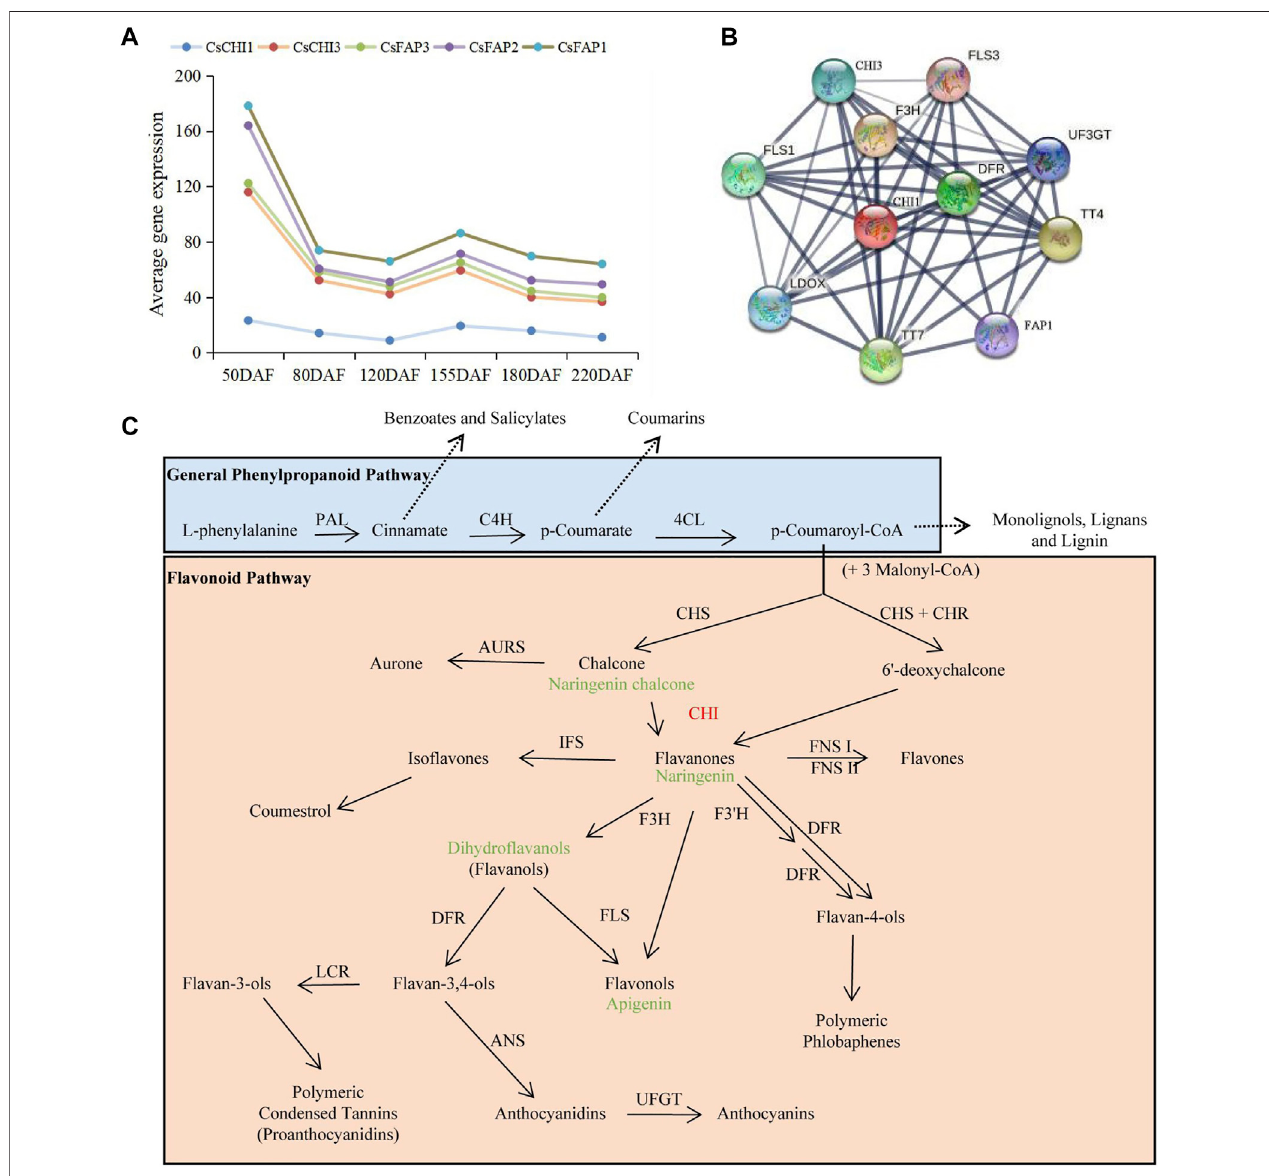
FIGURE 7 | molecular regulation mechanism of CHI genes. (A) Expression trend of CHI genes during the fruit development. (B) Interaction networks of the CHI based on their ortholog proteins to A. thaliana . (C) Flavonoid biosynthetic pathway.